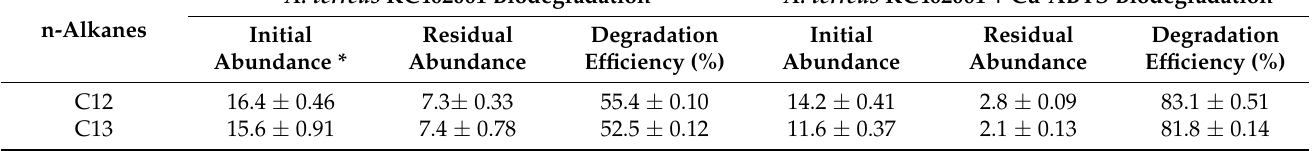
Table 2. Biodegradation efficiencies of A. terreus KC462061 and A. terreus KC462061 + Cu-ABTS for C12 to C20 n-alkanes after 10